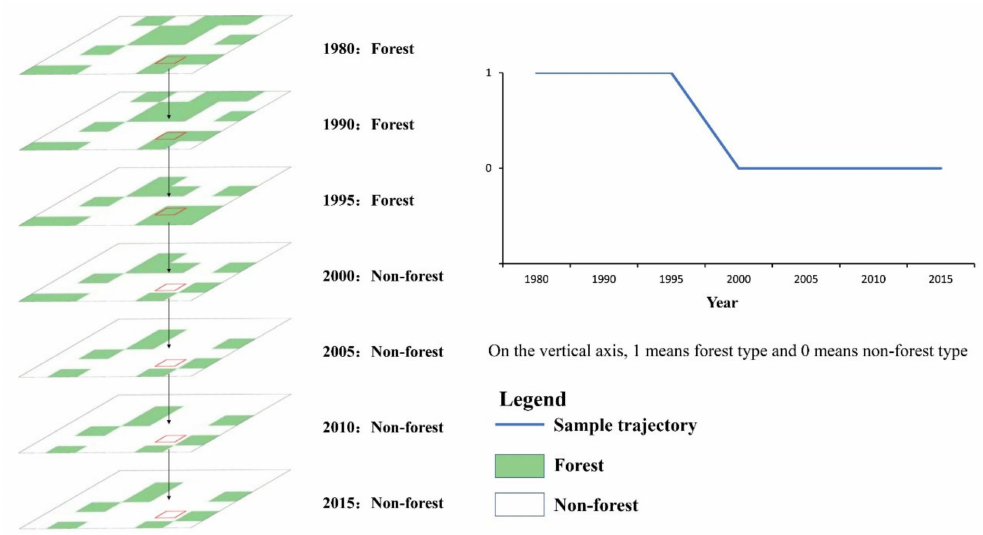
Figure 3. Example of forest temporal trajectory